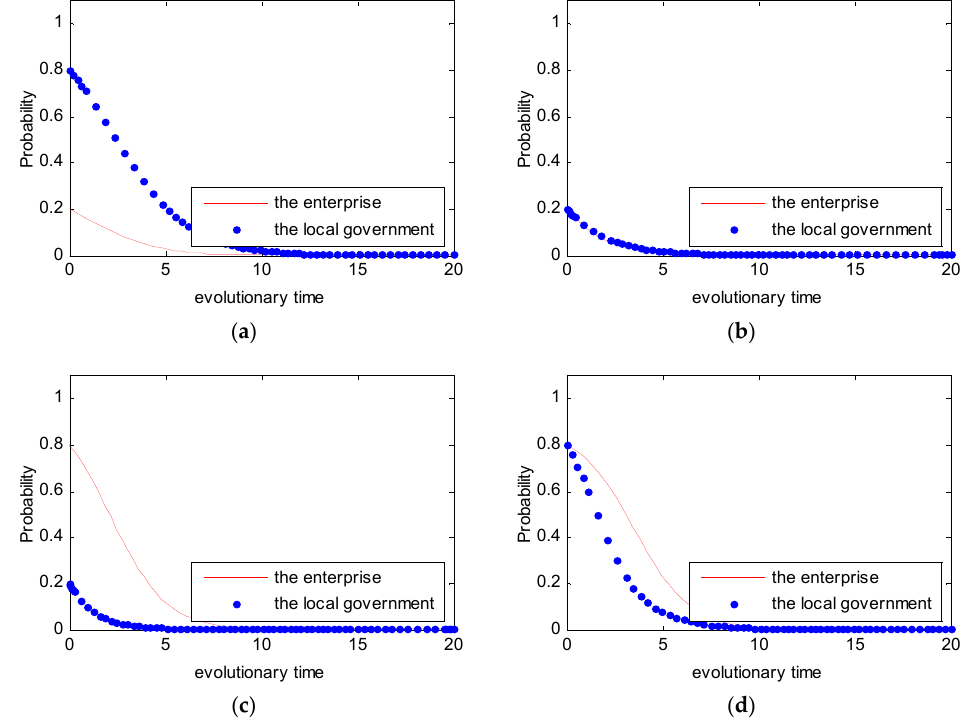
Figure 9. Probability of choosing a strong willingness strategy for di ff erent time t. ( a ) p t ( 0 ) = 0.2, q t ( 0 ) = 0.8; ( b ) p t ( 0 ) = 0.2, q t ( 0 ) = 0.2; ( c ) p t ( 0 ) = 0.8, q t ( 0 ) = 0.2; and ( d ) p t ( 0 ) = 0.8, q t ( 0 ) = 0.8